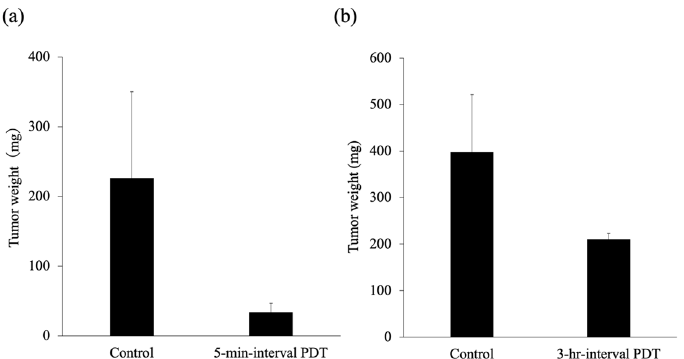
Figure 13. The mean tumor weight 25 days after photodynamic therapy (PDT). ( a ) The 5-min-interval PDT. ( b ) The 3-h-interval PDT. The results are presented as the mean ± standard deviation.